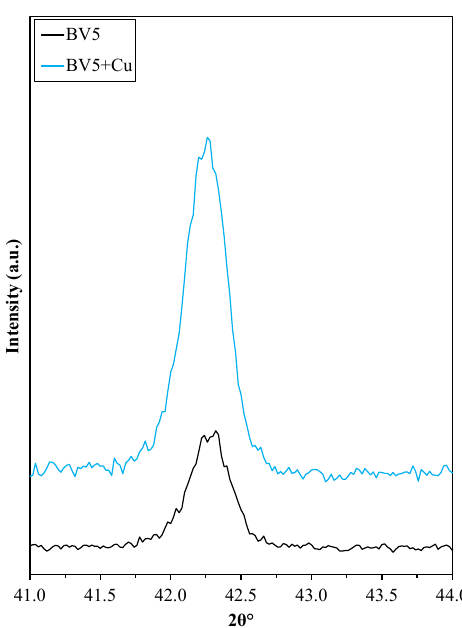
Figure A1. The di ff raction pattern of sample with and without Figure A1. The diffraction pattern of sample with and without Cu.